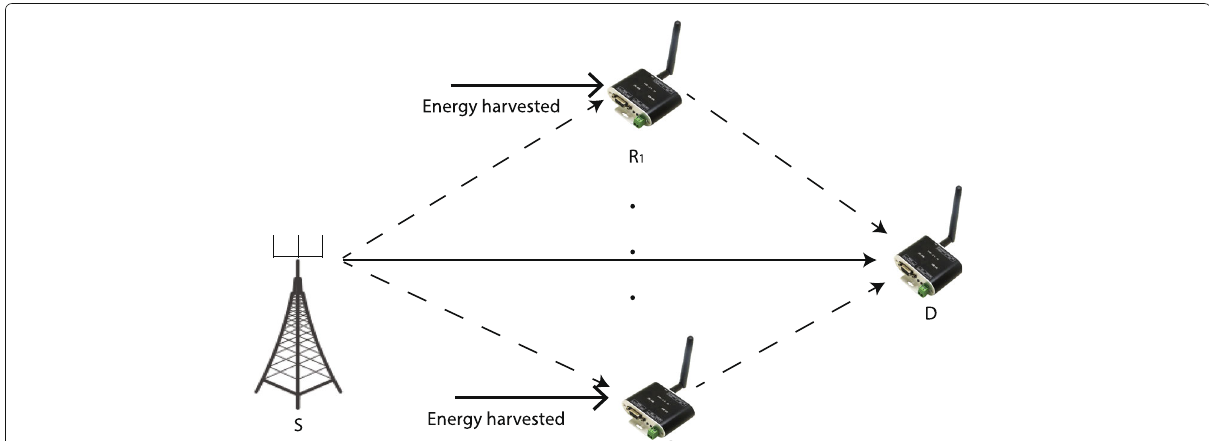
Fig. 1 A system structure for energy-harvesting relay-aided cooperative network with K available relay nodes, and the information flow is intended to be transmitted from S to D , where the solid line denotes direct link and the dashed line denotes relay link